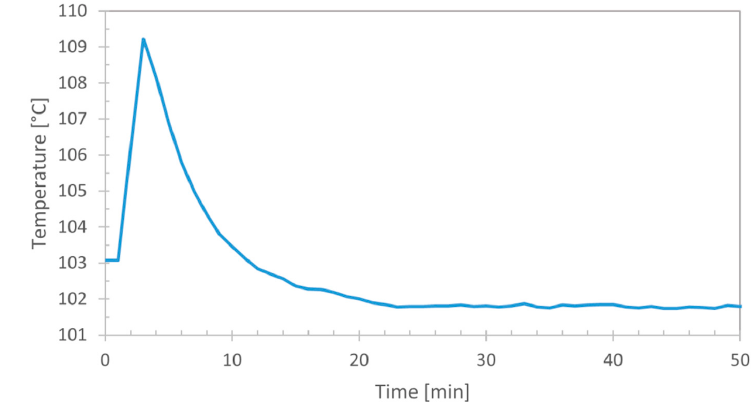
Figure 3. The course of hydrosilylation presented as the time dependence of temperature.